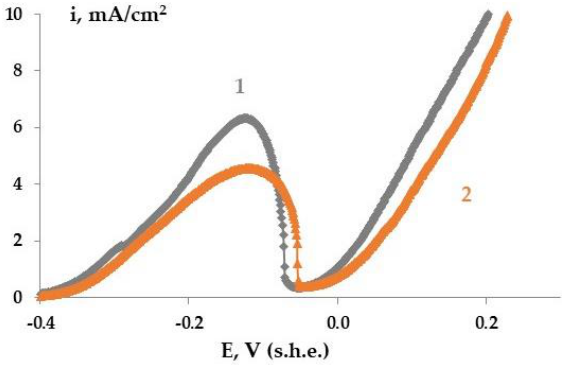
Figure 3. Anodic polarization potentiodynamic curve of St3 carbon steel in 0.1 M NaCl solution: 1 — non-modified steel, 2 — steel pre-modified with a VS solution. Potential scan rate: 1 mV/s.